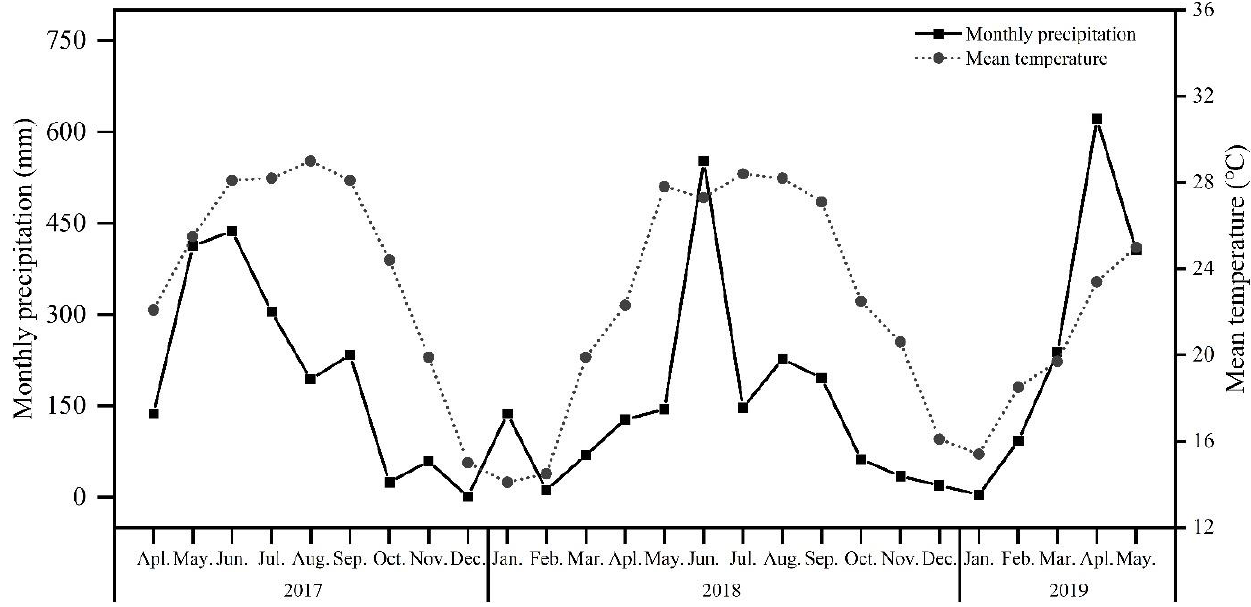
Figure 1. Monthly precipitation and mean temperature from April 2017 to May 2019 before standard tree cutting. The square pattern with the solid line indicates the monthly precipitation and the circle pattern with imaginary line represents the mean temperature. Table 1. The relative soil water content (%) from April 2017 to May 2019, before sampling.